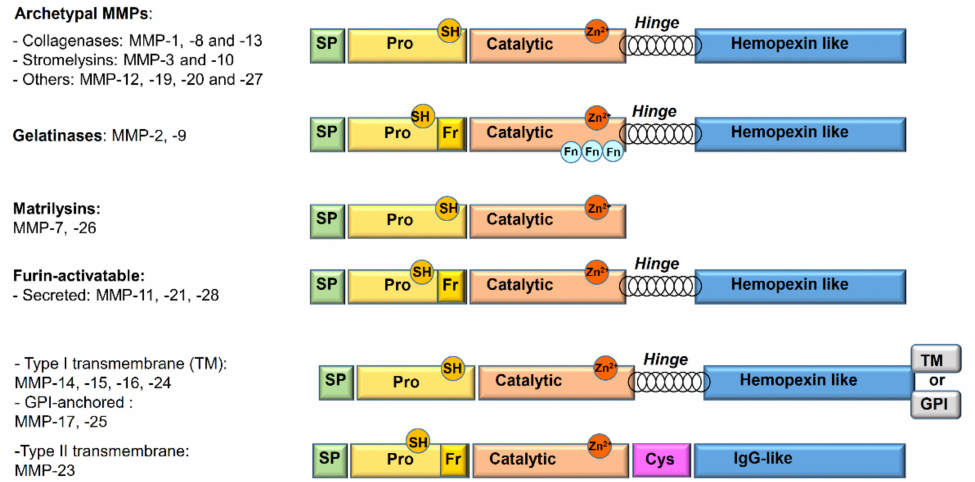
Figure 1. Schematic overview of the matrix metalloproteinase (MMP) domains and family member classification. SP: signal peptide; Pro: propeptide; TM: transmembrane domain; GPI: glycosylphosphatidylinositol; Cys: cysteine array; Fn: fibronectin repeat; Fr: furin-cleavage site; SH: thiol